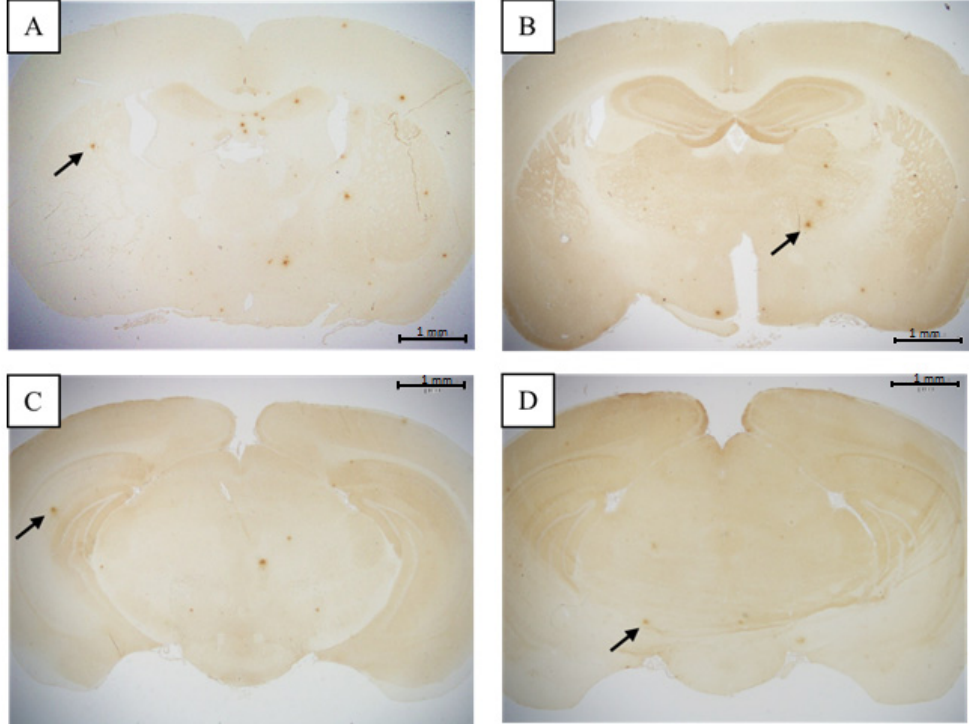
Figure 6. β -amyloid plaque in female mice (20× magnification). ( A ) = control (ddH 2 O), ( B ) = low dose (108 mg/kg BW/day), ( C ) = medium dose (215 mg/kg BW/day), ( D ) = high dose (431 mg/kg BW/day) (n = 5). Arrows indicate β -amyloid plaque.